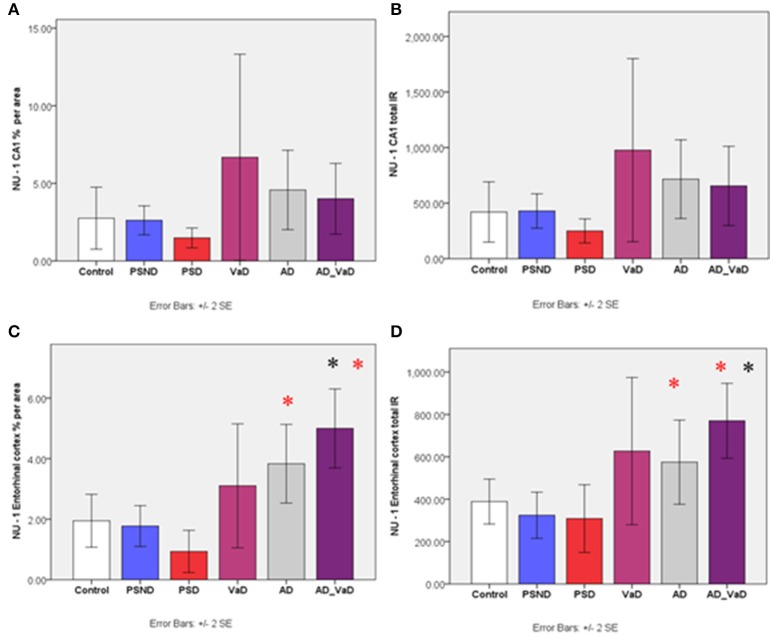
Bar graph shows percentage area and immunoreactivity of soluble Aβ (IR) across the CA1 region (A,B) and Entorhinal cortex (C,D) respectively in Control PSND, PSD, VaD, AD, and AD_VaD. Bars show ± 2 SEM *Mann Whitney U-test was used to compare means of each group. *p < 0.05 (in comparison with the *control group and *PSD group). There were no significant differences across groups in the CA1, CA2, and CA3 regions (p > 0.05, Kruskal–Wallis Test).